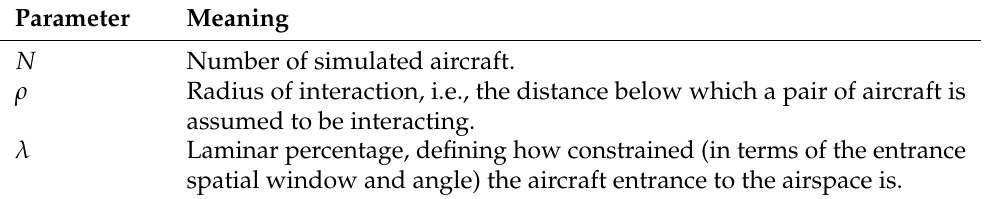
Table 1. List of parameters defining the behavior of the synthetic model, and description of their meaning. Parameter